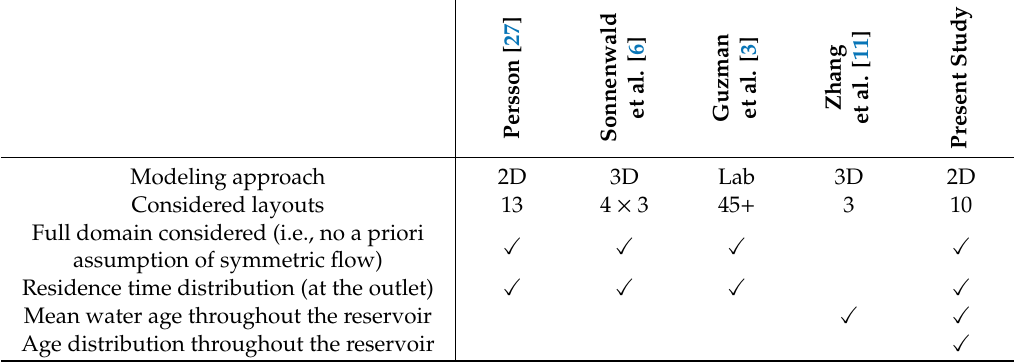
Table 1. Contribution of the present study compared to the existing